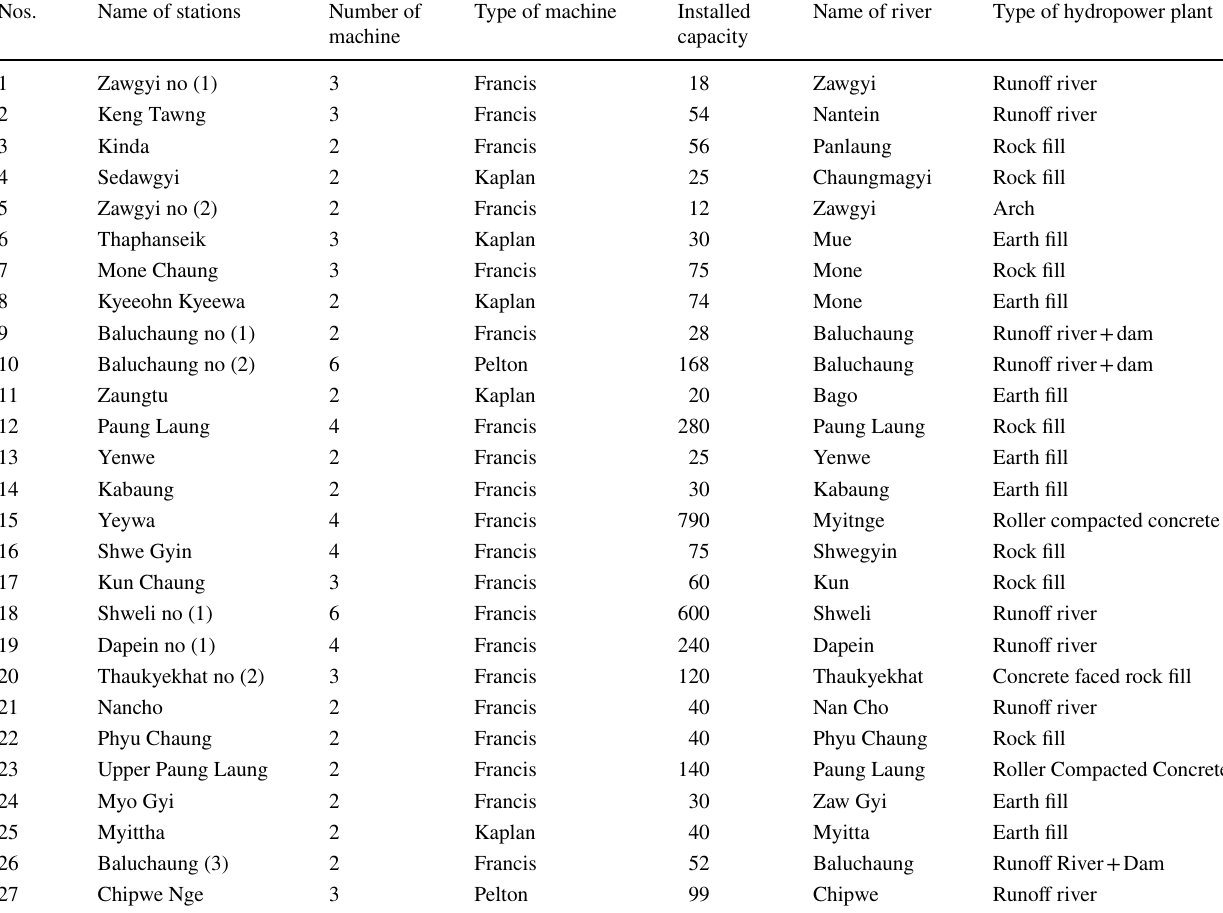
Table 1 Current hydropower stations in Myanmar